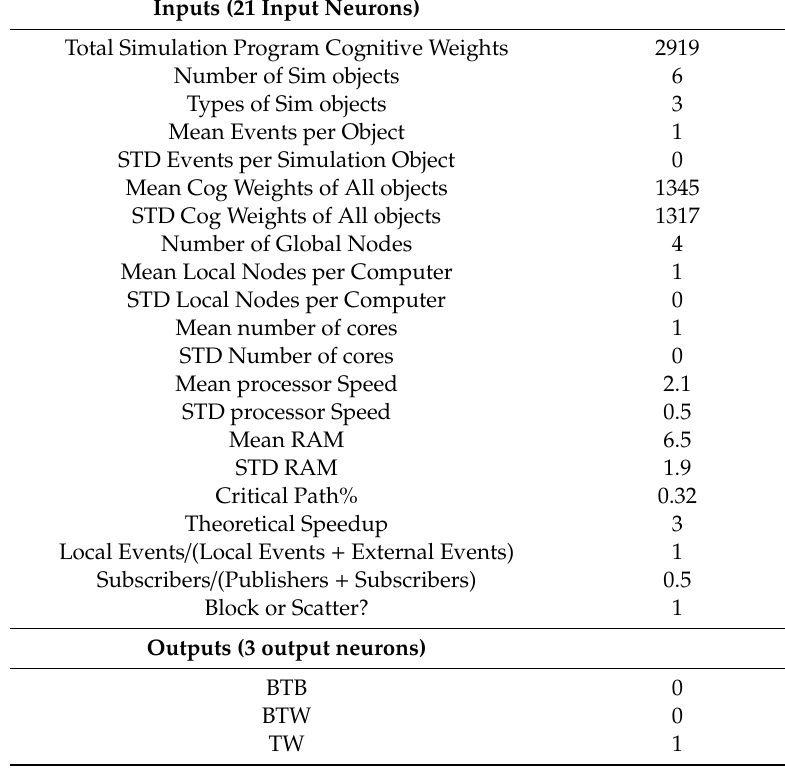
Table 5. Example of a vector that defines the parallel distributed discrete-event simulation (PDDES) implementation for the aircraft detection model of Figure 7 with 4 global nodes and 1 local node using block as the distribution policy, with TW as the best performance (best wall-clock